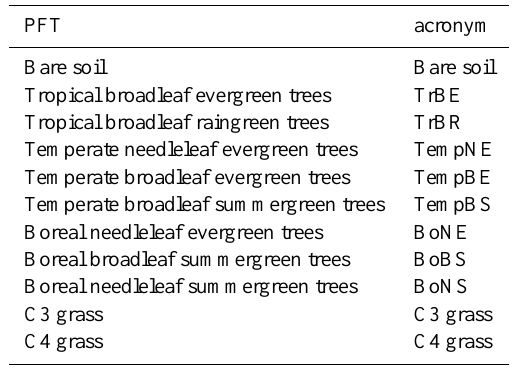
Table 1. Plant functional types (PFT) in ORCHIDEE and acronyms used in this study. PFT acronym Bare soil Bare soil